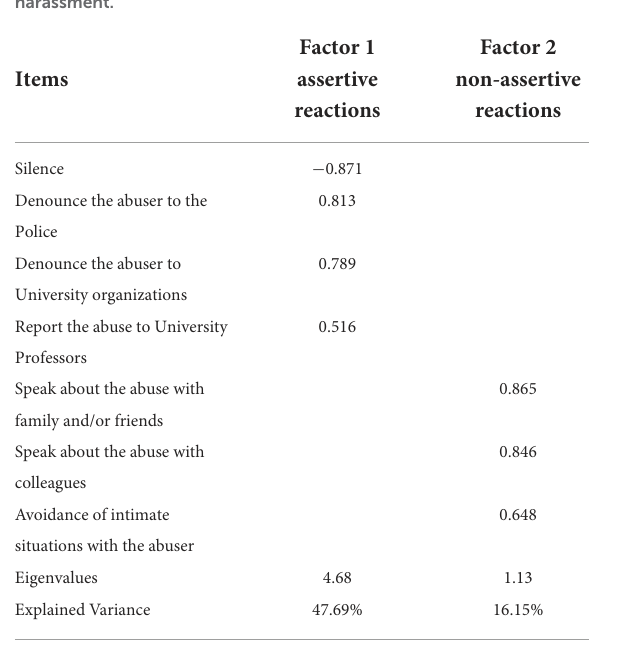
TABLE 2 Principal component analysis (PCA) of the reactions to sexual harassment.